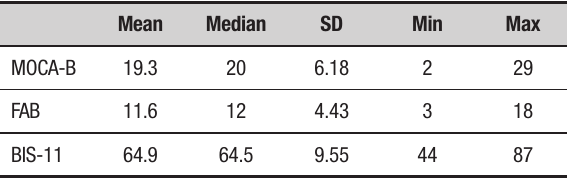
Table 2. Raw scores on the scales and tests.